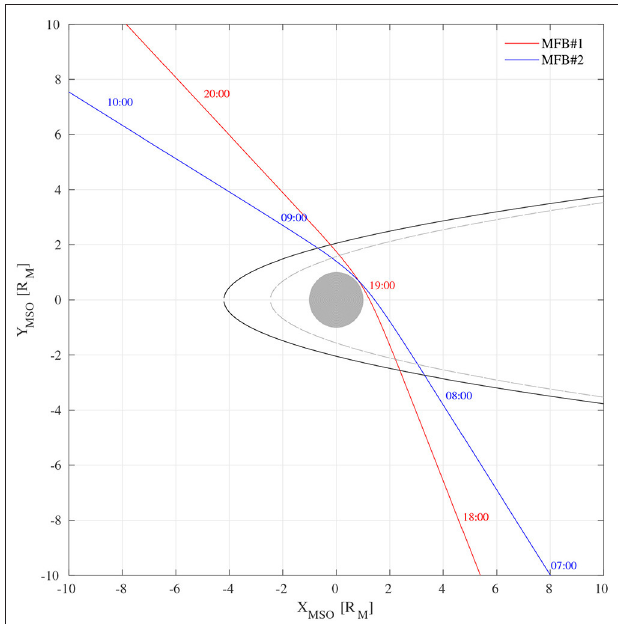
FIGURE 1 | The trajectories in the X MSO − Y MSO plane for the first (red) and the second (blue) Mercury flyby, respectively. The gray and the black lines refer to the bow shock and magnetopause models [ 3, 24], respectively. Time labels refer to the 2 days (i.e., January 14, 2008 and October 6, 2008) and are expressed in UT.